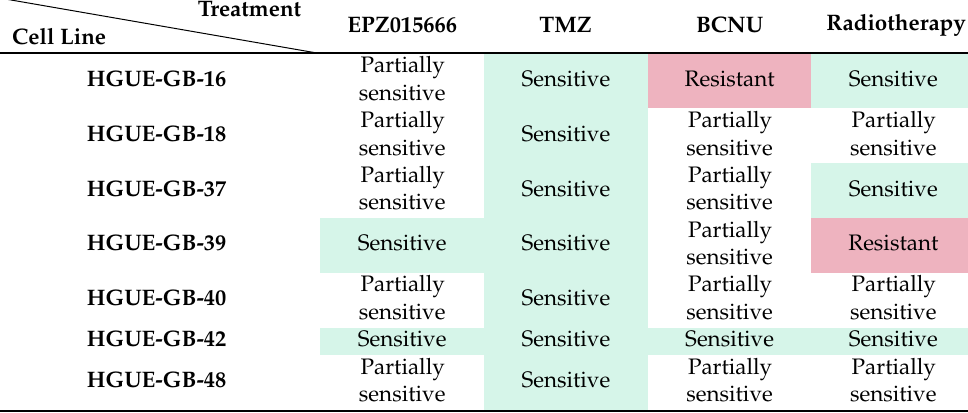
Table 1. Sensitivity and/or resistance classification of GBM lines to treatments. GBM cell lines classification according to their sensitivity and/or resistance to EPZ015666, TMZ, Carmustine (BCNU), and radiotherapy treatments. Cells were treated with different concentrations of the chemotherapeutic agents EPZ015666 and TMZ. Classification of BCNU and radiotherapy data was performed based on data previously reported by our research group [26]. Classification of those treatments is based on the IC 50 of each one. The resistant cell lines of each treatment are highlighted in red and the sensitive ones are highlighted in light green. GBM, glioblastoma; TMZ, Temozolomide. Cell